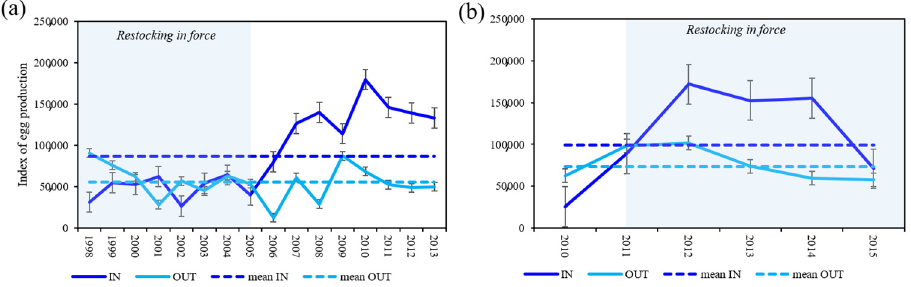
Figure 8. Annual trend of index of egg production (IEP) inside and outside Su Pallosu ( a ) and Buggerru ( b ). Means ± SD. Solid lines, IEP; stripped lines, mean IEP.